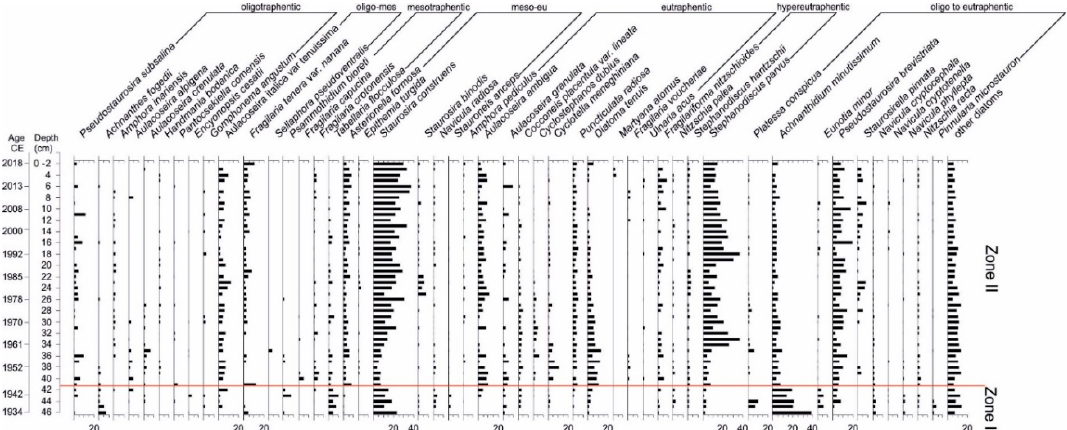
Figure 8. Relative abundance of dominant diatom species in Lake Sekšu (species with values >2%).